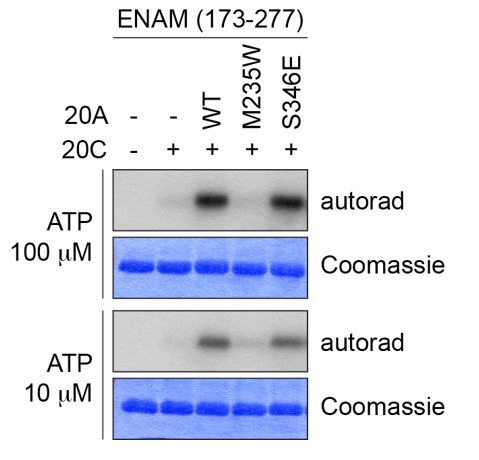
DOI:
http://dx.doi.org/10.7554/eLife.23990.012